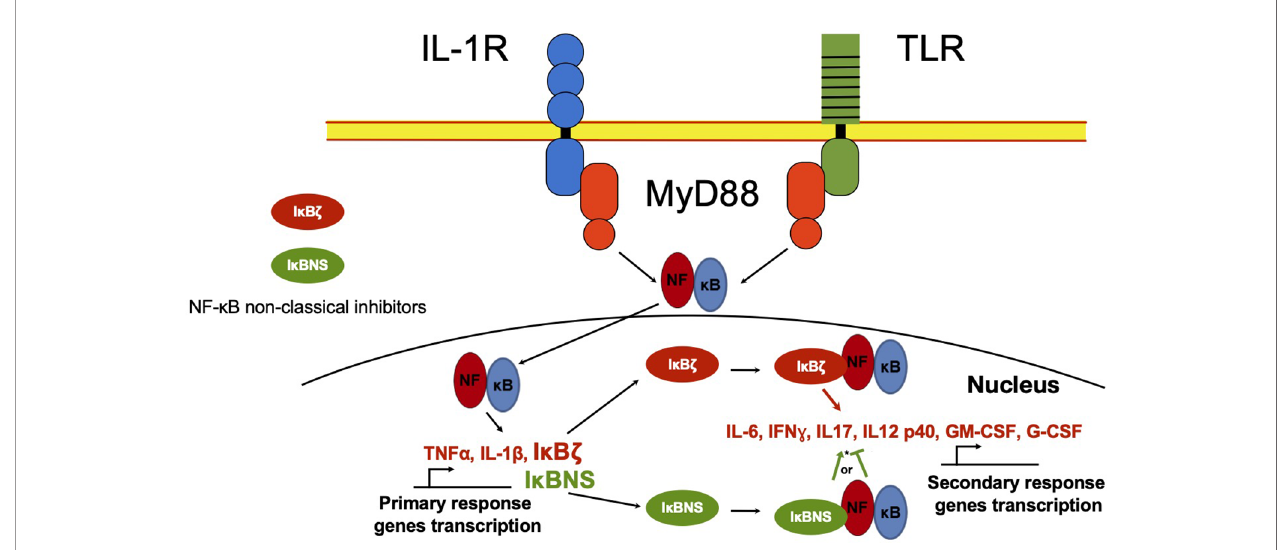
FIGURE 3 | NF- k B non-classical regulators in the nucleus. NF- k B in the nucleus regulates the transcription activity of primary response genes. Non-classical NF- k B regulators such as I k B z and I k BNS proteins, can interact with NF- k B and recruit it to the promoter of secondary response genes like IL-6 or IFN g , inducing or inhibiting gene transcription. *I k BNS can act as NF- k B promoter or inhibitor depending on cell type and